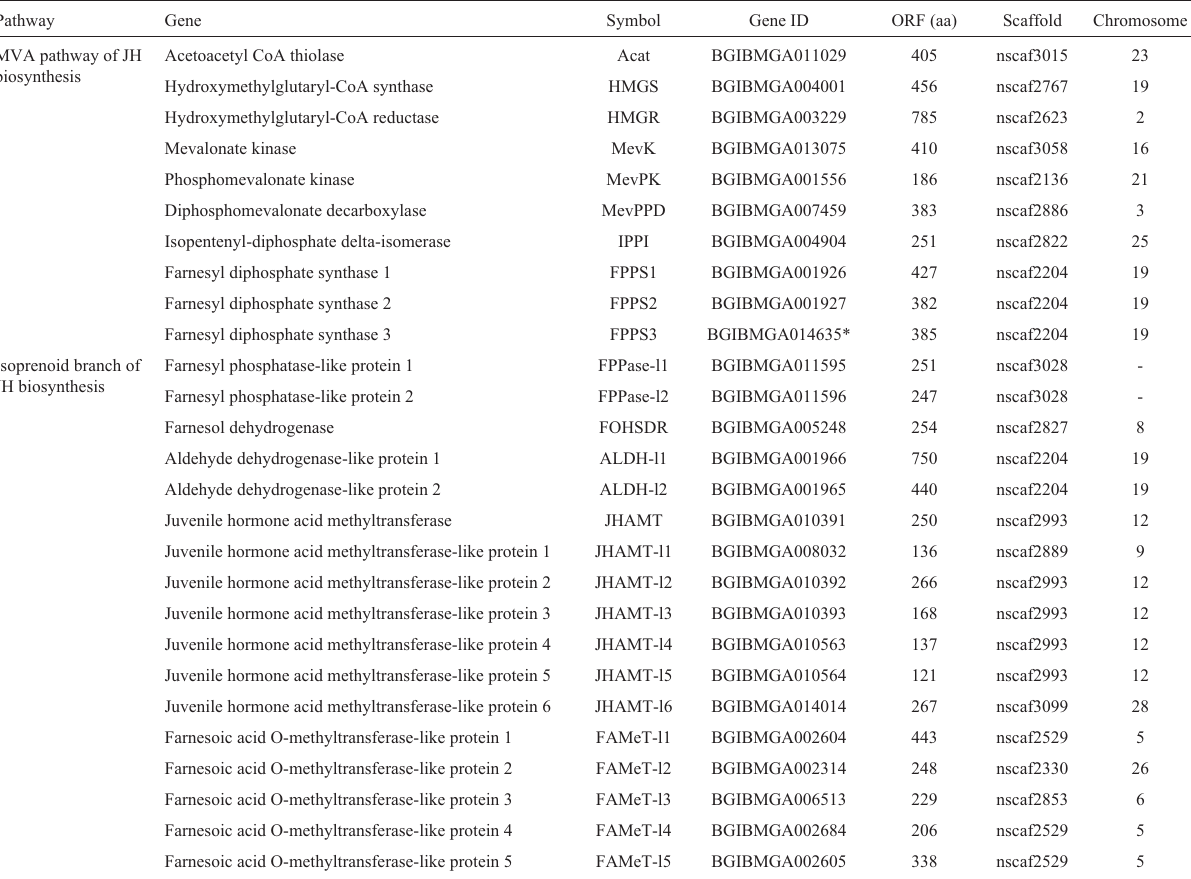
Table 1 - Inventory of JH-related genes in the B. mori genome. Pathway Gene Symbol Gene ID ORF